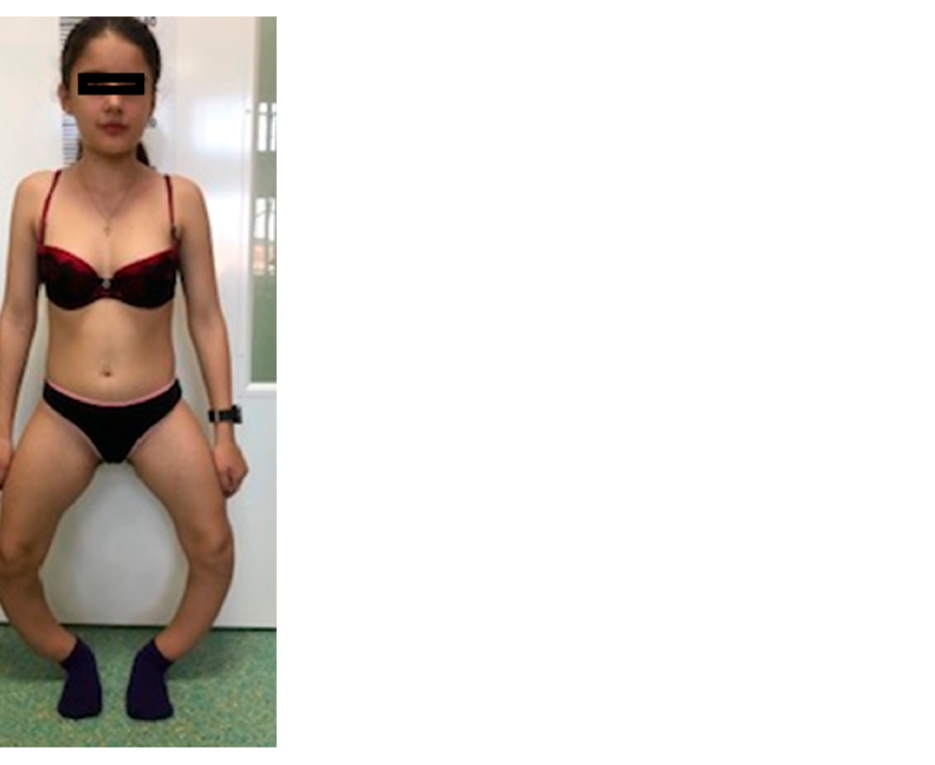
Figure 1. Case #1. Sister at 13 1 years old: short stature, genu varum deformation of lower limbs. 2